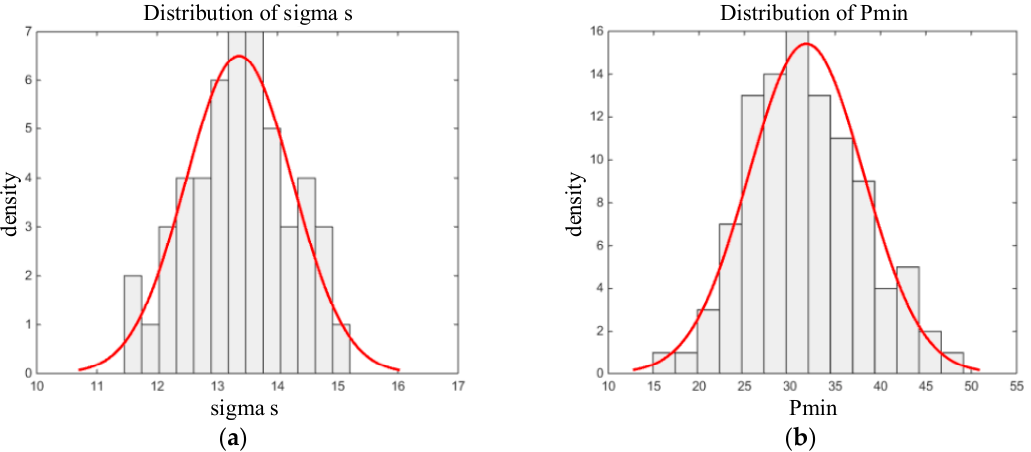
Figure 4. ( a ) Compressive stress and ( b ) contact stress distribution nephograms.